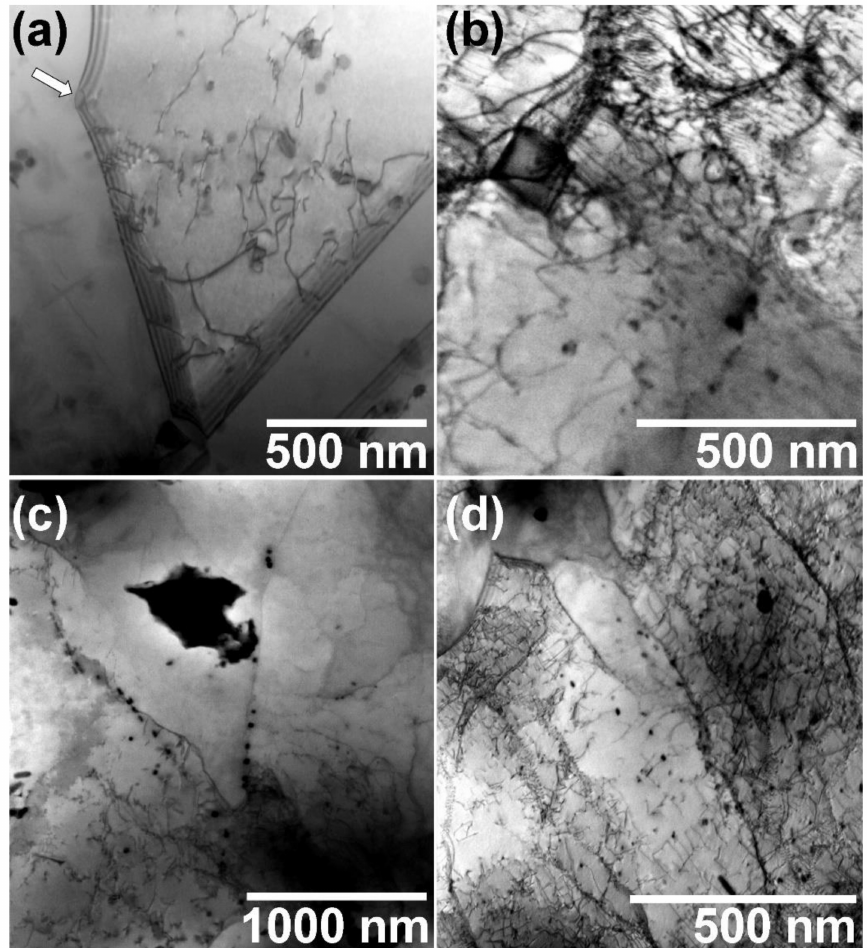
Figure 10. Thin-foil TEM analysis of the ISO steel soaked at 1250 ◦ C after 13 passes with 20 s of interpass time. A clear interaction of precipitates with grain boundaries and dislocations is observed in four random areas. ( a ) Twinned region with some dislocations, precipitates, and thickness fringes. ( b , c ) Regions with a high density of dislocations and precipitates randomly dispersed in the austenitic matrix. ( d ) Grain boundary temporarily retained by small particles with short spacing in between